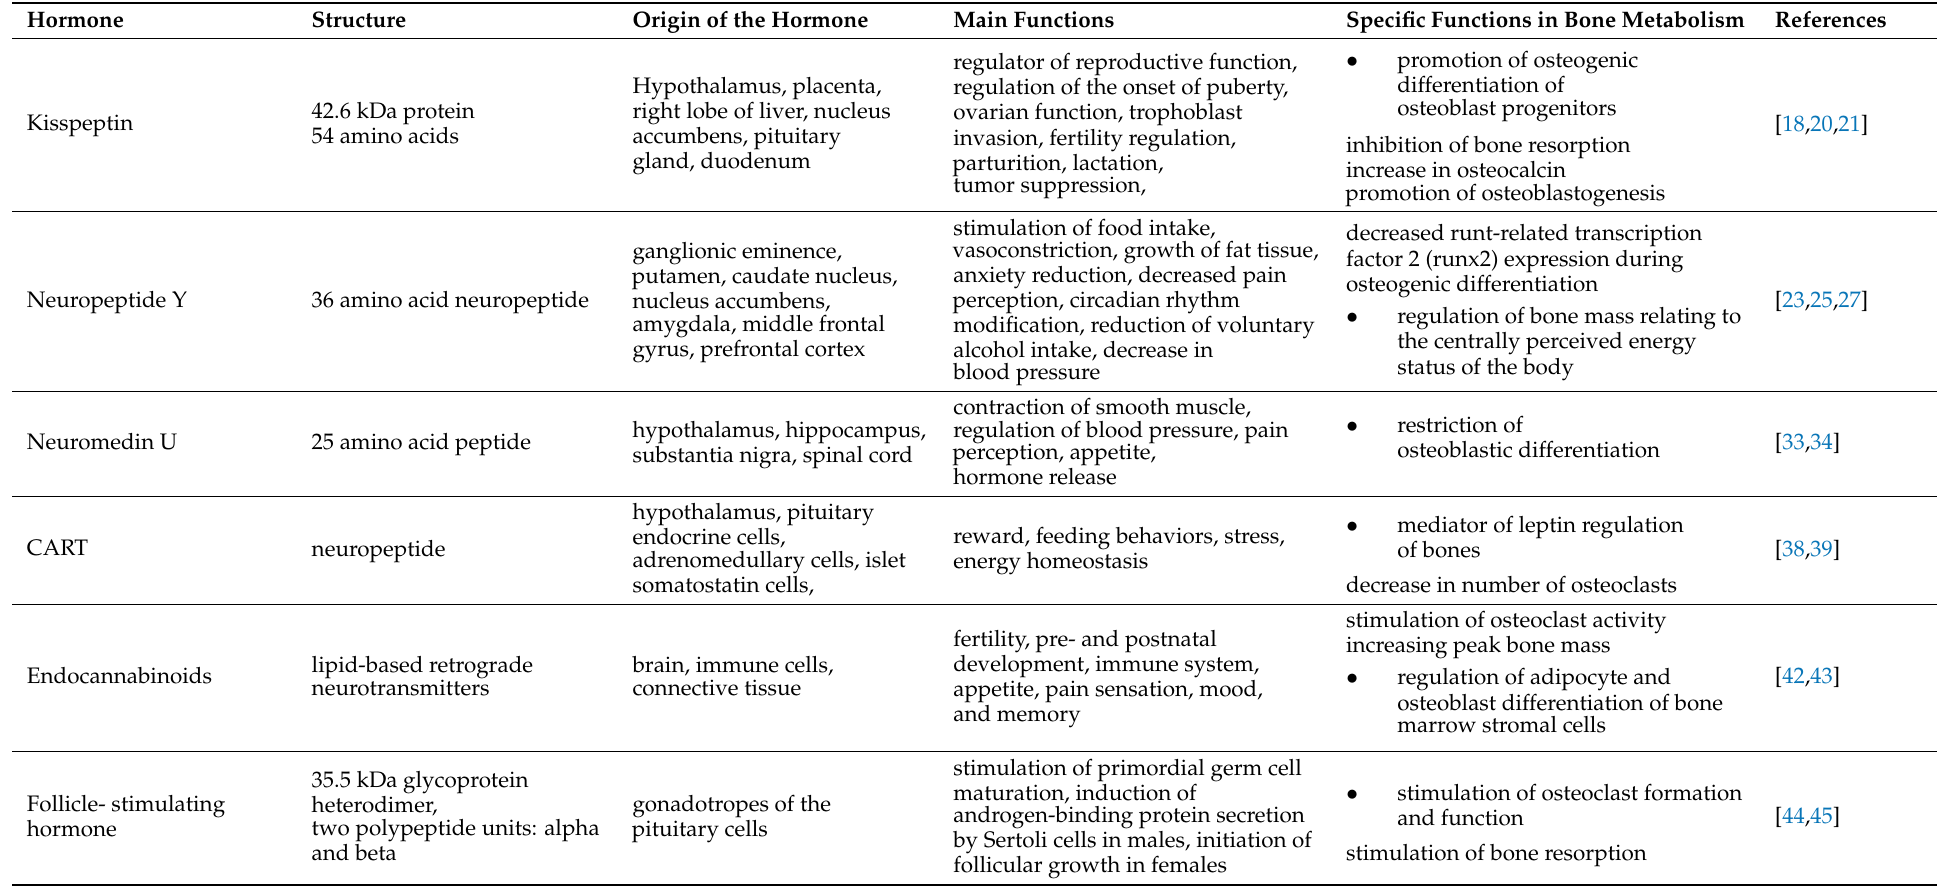
Table 1. Summary of origin, main functions and specific function in bone metabolism of the preeminent hormones included in this